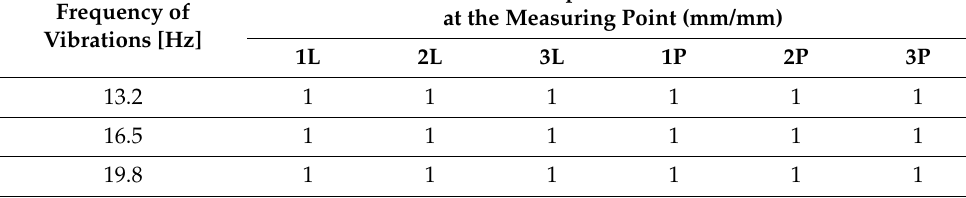
Table 5. Maximum multiples of vibration amplitude values in the x direction. Frequency of